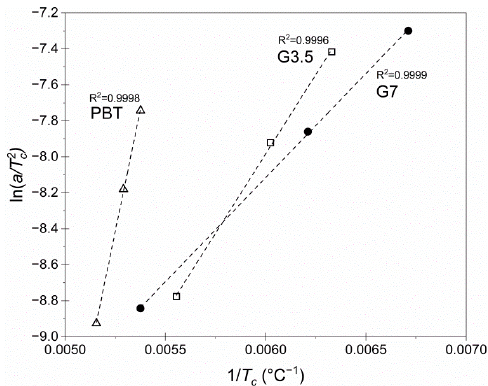
Figure 6. Arrhenius plots for the neat PBT, G3.5 and G7 vitrimers at the optimum SSP conditions (3 h at 180 °C).